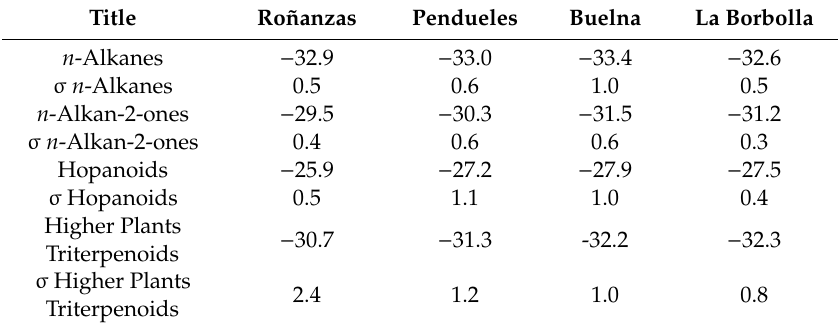
Table 4. Average δ 13 C values (% (cid:24) ) of some compound families in the di ff erent peat profiles with the corresponding standard deviations ( σ